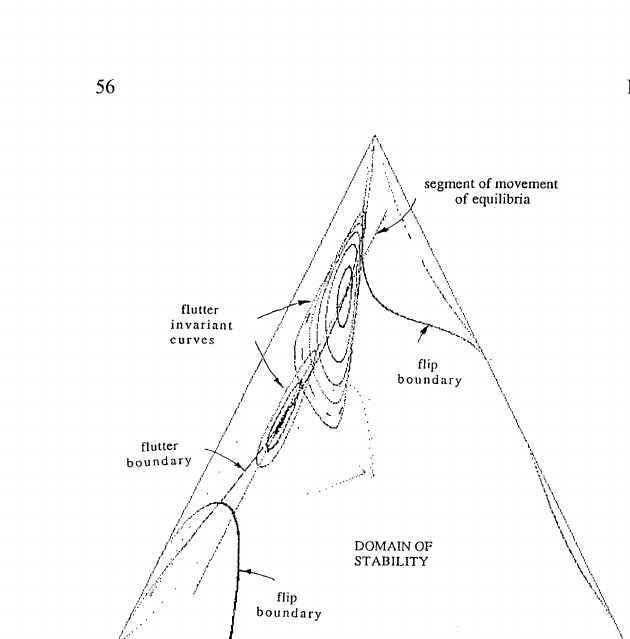
FIGURE 5 Planar bifurcation diagram: one population/ three location relative